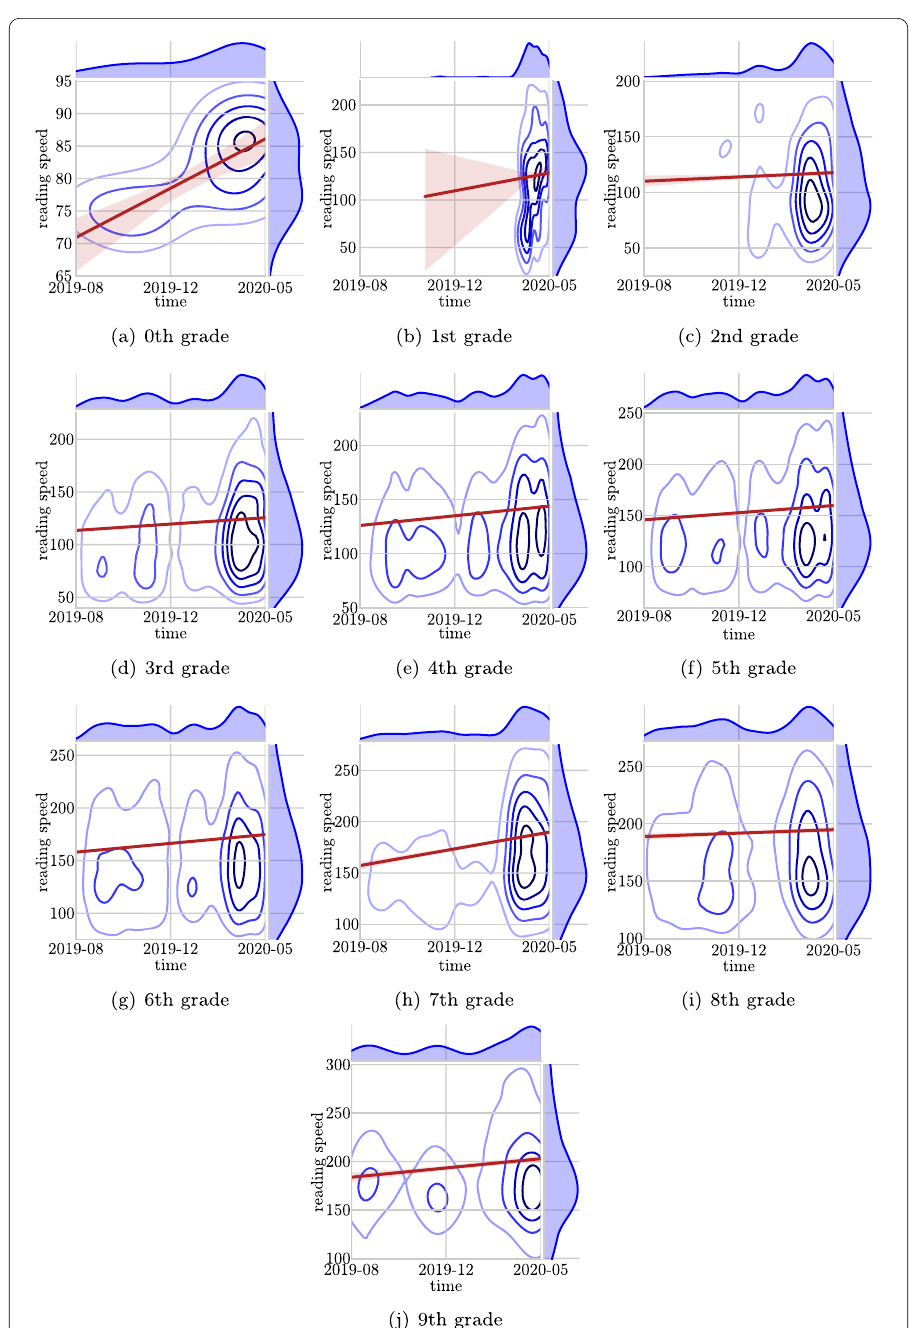
Figure 4 Kernel density plots, predicted line and confidence intervals for reading speed over time. Per grade